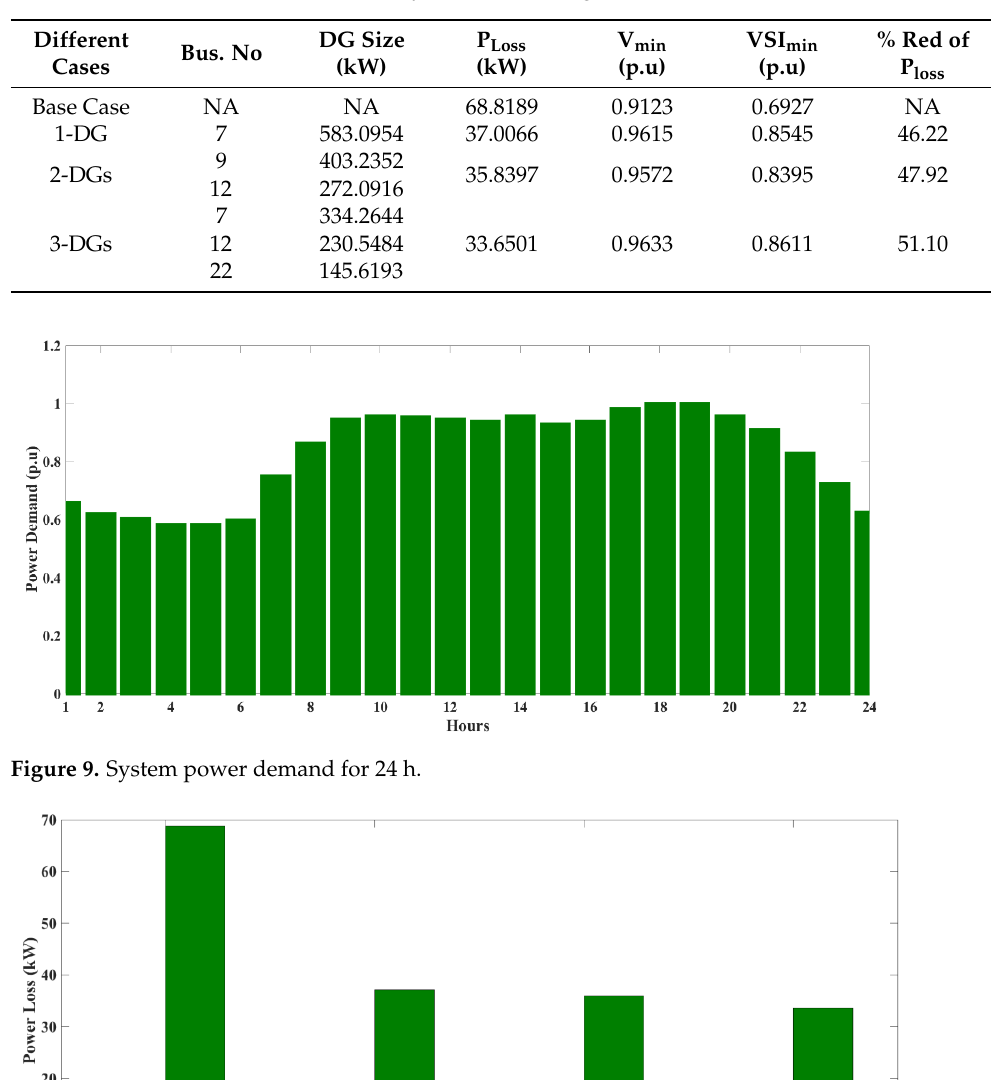
Table 5. DG sizes under dynamic load profile without considering uncertainties. Table 2. Results for 28 Indian Real Test System considering different cases.